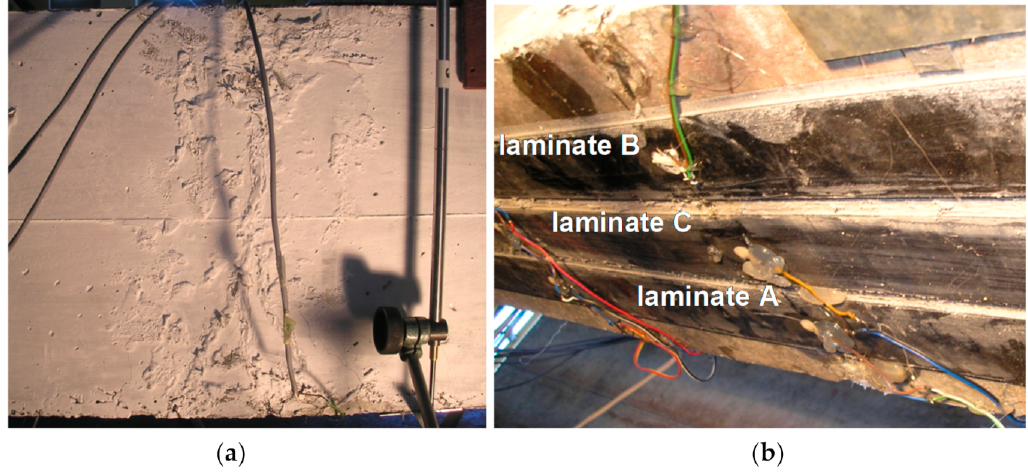
Figure 8. The repaired beam in the main breakage region: ( a ) side view and ( b ) bottom view. Before the main damage test, the repaired beam was tested in few levels of static and cyclic loading. The first group consisted of three monotonic load cycles up to the force of 120 kN. In the fourth primary test, the beam was investigated in 11,000 cycles of load in the force range 30–110 kN with a frequency of 2 Hz. During this test, no damage was observed. After these tests, the main static test up to the failure was carried out with the dis- placement rate of 1 mm/min (displacement of the actuator jack). In the first phase of load, all CFRP laminates worked up to the maximum external force of 158.1 kN when the first of the side laminates (marked as A) was detached. Consequently, eccentric distribution of internal forces occurred and soon afterwards the second side laminate (B) also detached.